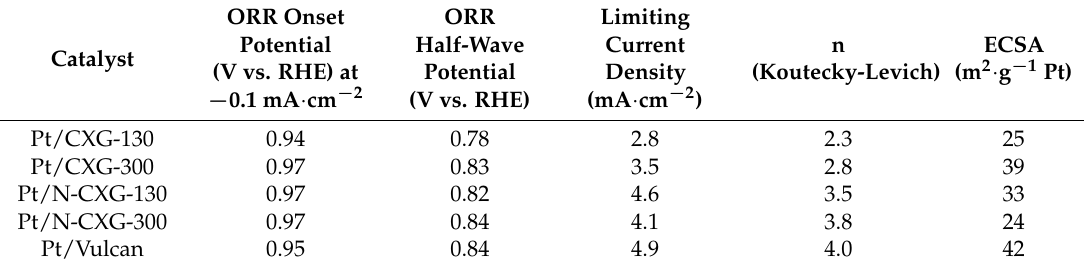
Table 5. Kinetic parameters obtained from RDE measurements (potential vs. RHE), along with the electrochemical surface area (ECSA) calculated from cyclic